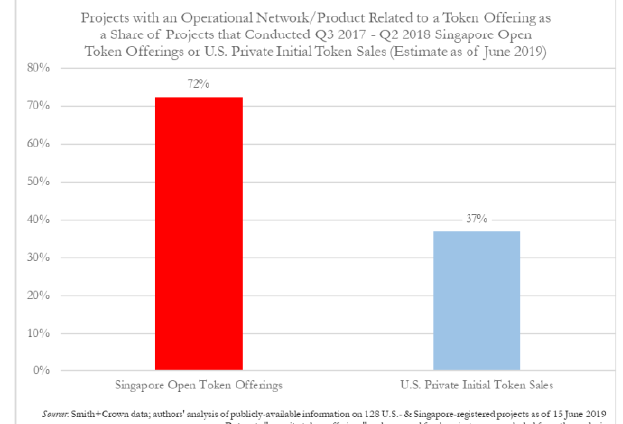
Figure 3. A greater share of one-to-two-year-old Singapore open digital token offerings resulted in operational networks and products relative to Q3 2017 - Q2 2018 U.S.